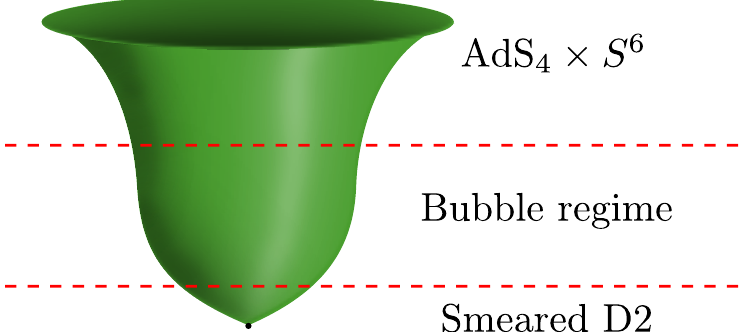
Figure 2: A conceptual picture of the radial evolution of the bubble geometry. The "dilaton bubble" is a good intermediate description. In the large distance limit it connects to the vacuum phase. Moreover, the bubble regime cannot persist indefinitely at small distances and it ultimately flows to a (smeared) D2 brane